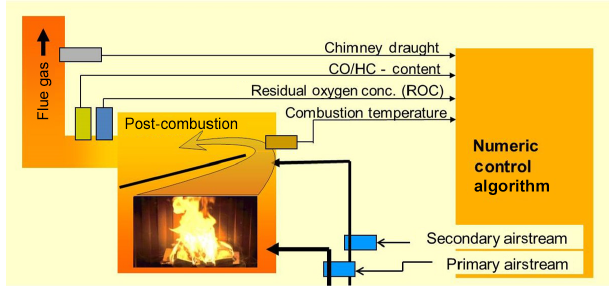
Figure 1. Schematic drawing of a wood-log-fuelled fireplace with indication of the primary and secondary combustion airstreams con- trolled by mass flow sensor–shutter systems (blue). The various sen- sor elements and their positions are